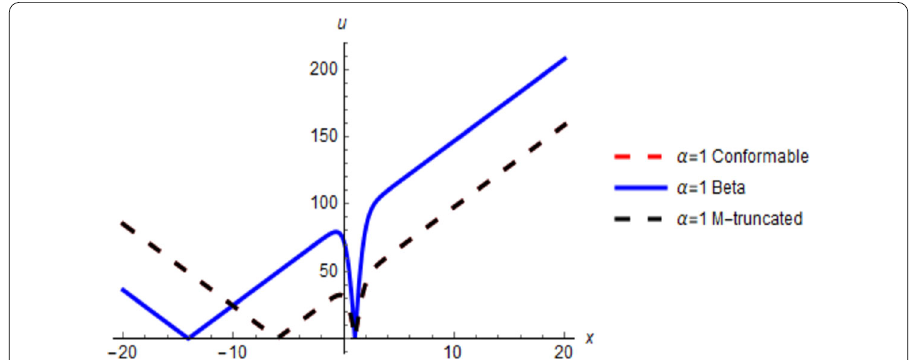
Figure 5 2D-plot with α = 1, β = 0 of u 1 ( x , t ) for different derivatives